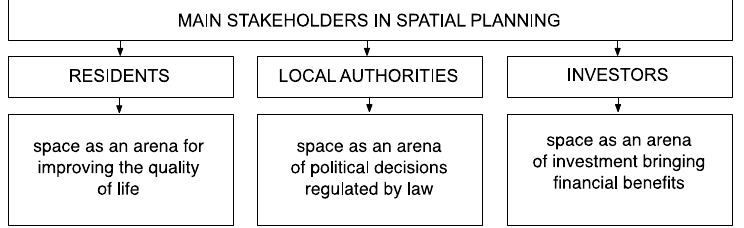
Figure 7. The importance and role of space among different stakeholders in the process of spatial development. Source: own elaboration.